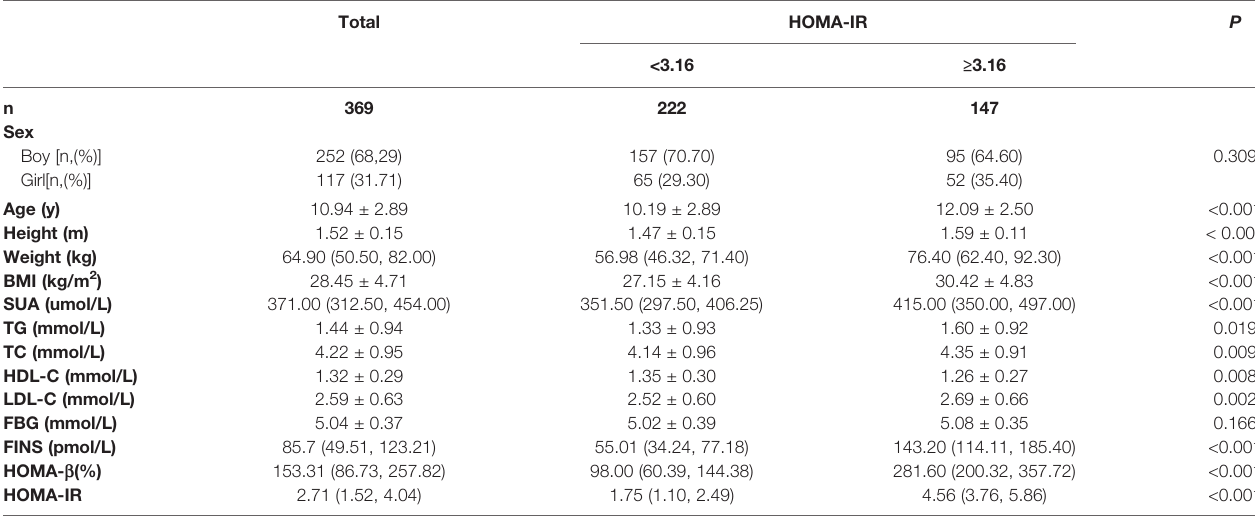
TABLE 1 | Participants characteristics in different HOMA-IR groups among total sample.